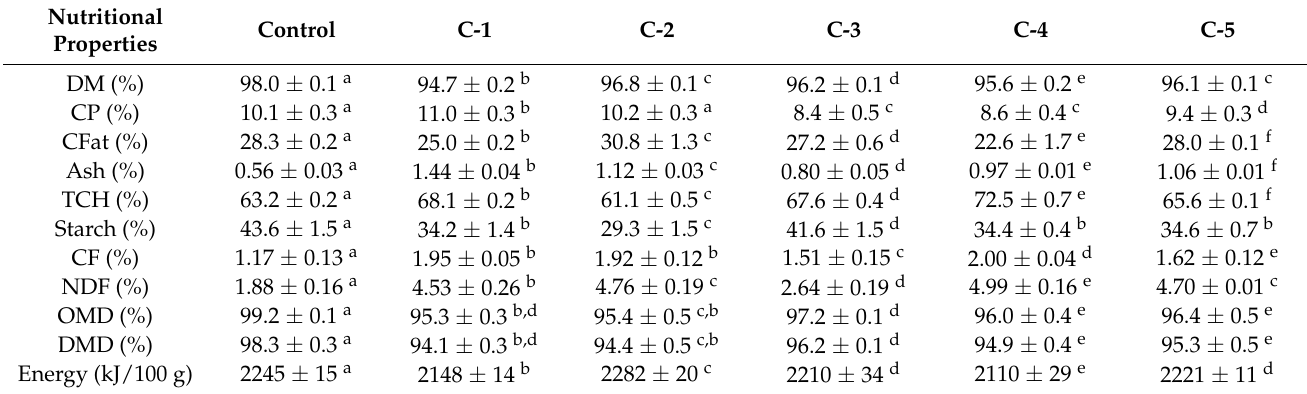
Table 2. Chemical compositions and in vitro digestibility values of the